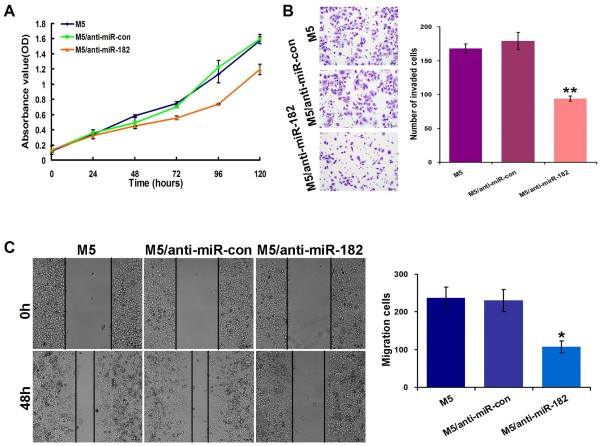
The down-regulation of miR-182 expression repressed aggressive phenotypes of CRC cells in vitro. (A) Inhibition of miR-182 inhibited cell proliferation of SW620 cells by CCK8 assay. (B, C) Inhibition of miR-182 reduced cell invasiveness and migration as determined by matrigel invasion chamber (B) and wound healing assays (C). Data were presented as mean ± SD. The results were reproducible in three independent experiments. * p < 0.05, ** p <0.001.